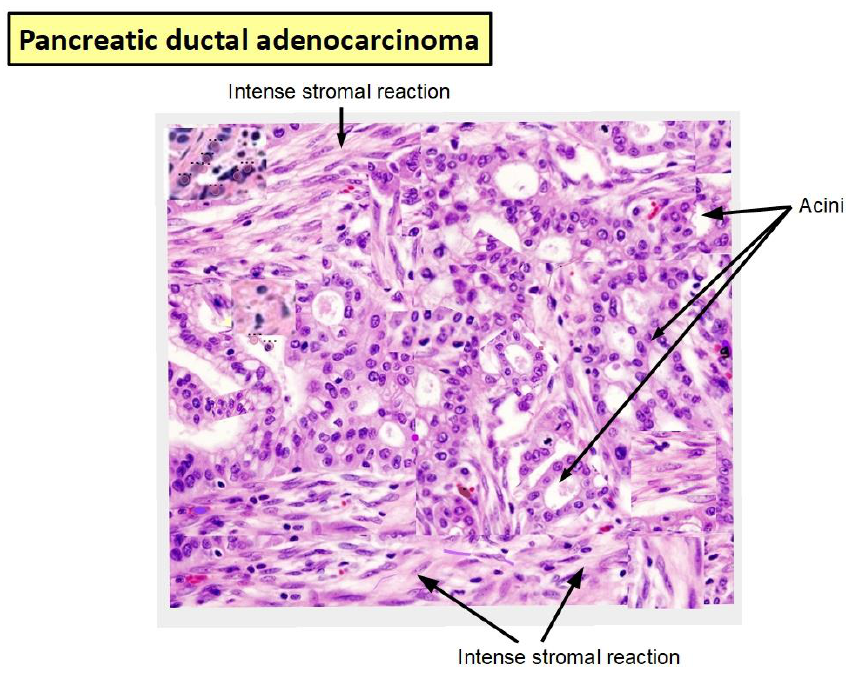
Figure 1. Tissue specimen of a pancreatic ductal adenocarcinoma (PDAC). Intense stromal reaction surrounding tumoral ducts and acini (from the personal collection of TK). Magnification 150×.